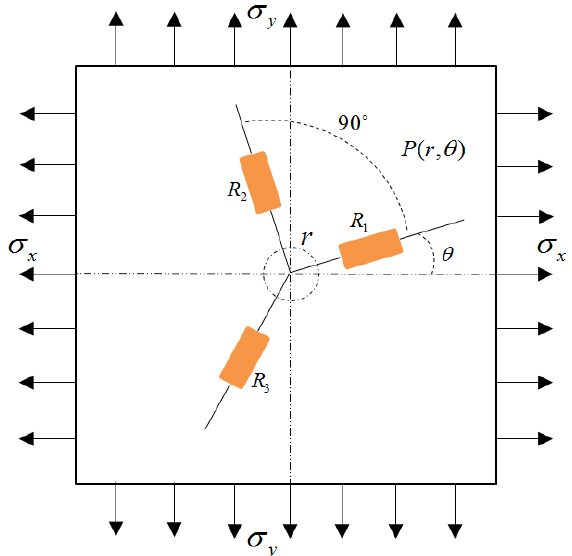
Figure 7. Diagram of sensitive grid arrangement θ is the angle between the principal stress σ x and the strain gauge R 1 , and the angle between the strain gauge R 2 and R 3 is 135 ◦ .